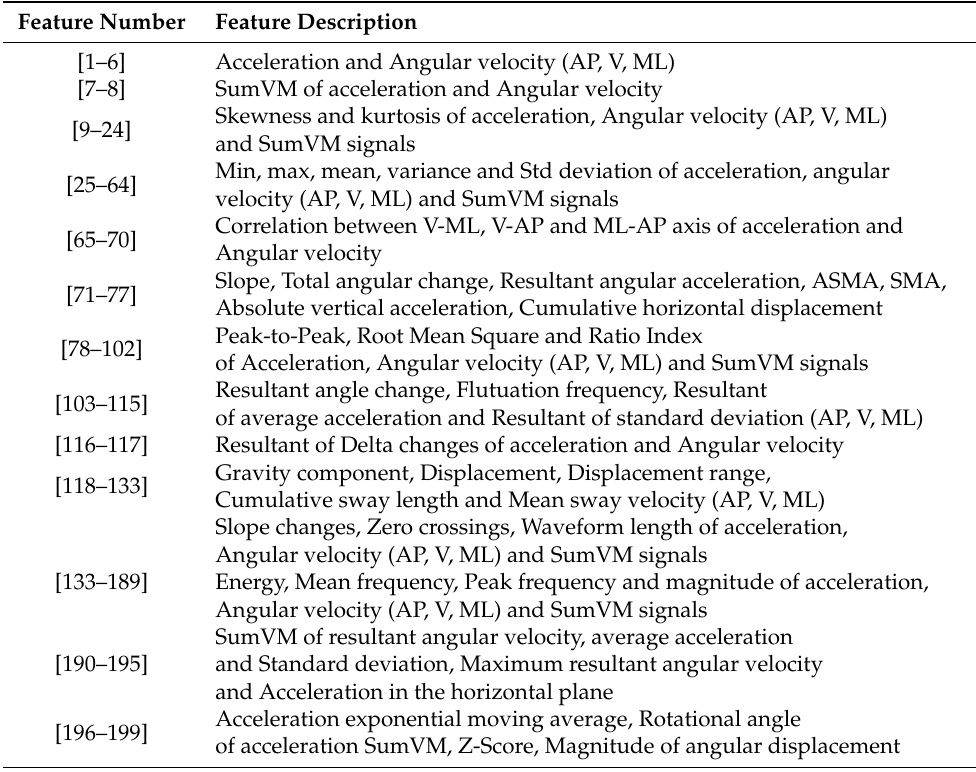
Figure 4. Signal segmentation example, using the sliding window technique example for feature extraction. A sliding window across time is represented by windows 1 to 3. Table 4. List of all extracted features from each window created. AP, V and ML refer to the anteropos- terior, vertical and mediolateral axis,